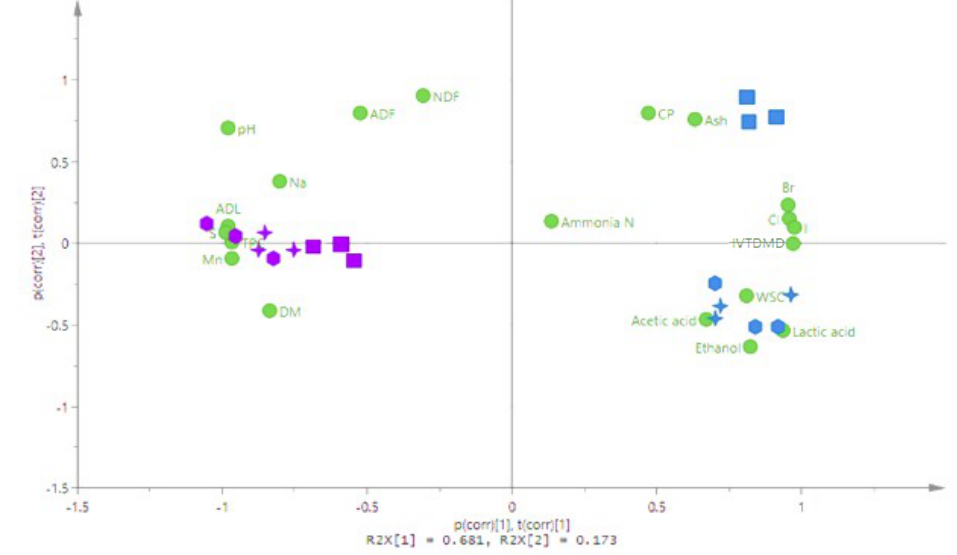
Figure 5. Biplot of principal component analysis showing the characteristics of F. vesiculosus (FV, purple) and S. latissimi (SL, blue) before and after ensiling, and with or without a Lactobacillus plantarum inoculant. Before ensiling = ⬛ ; after ensiling, untreated = ; after ensiling, inoculated = ✢ ; = FV and SL silages with and without inoculant; t(1)/(2) = Principal component 1 or 2. DM = dry matter; CP = crude protein; WSC = water soluble carbohydrate; aNDF = neutral detergent fibre; ADF = acid detergent fibre; ADL = acid detergent lignin; TPC = total phenolic content; IVTDMD = in vitro true dry matter digestibility.